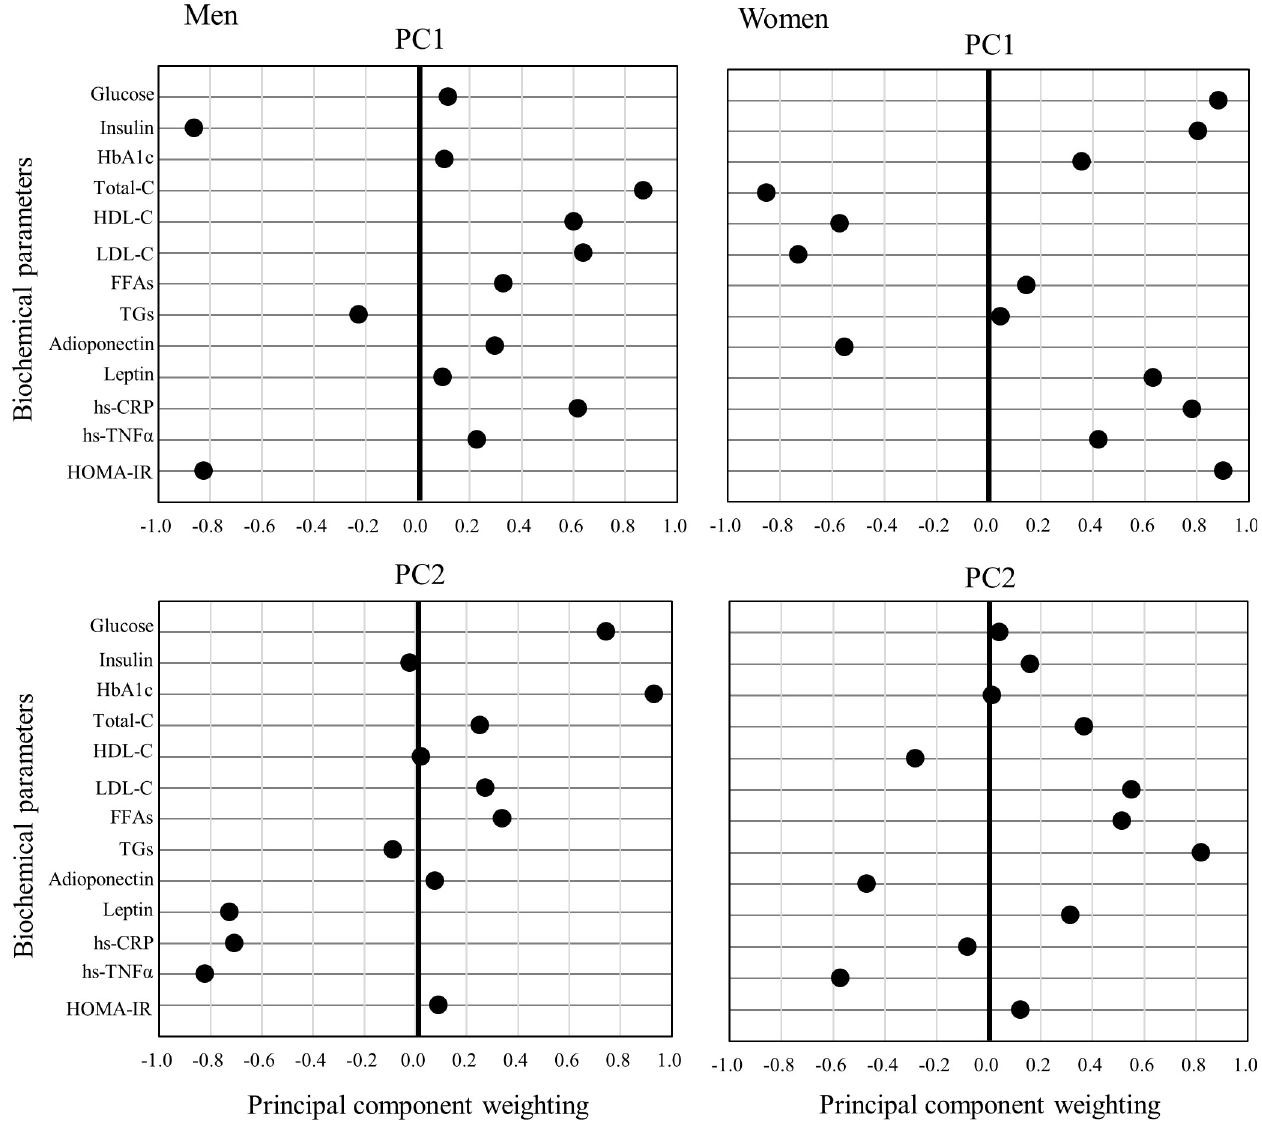
Fig 1. PC weighting in men (a, left side) and women (b, right side). FFAs, free fatty acids; HbA1c, hemoglobin A1c; HDL-C, high-density-lipoprotein cholesterol; HOMA-IR, homoeostasis model assessment index of insulin resistance; hs-CRP, high-sensitivity C-reactive protein; hs-TNF α , high-sensitivity tumor necrosis factor; LDL-C, low-density-lipoprotein cholesterol; TGs, triglycerides; Total-C, total cholesterol. PC weighting was significant ( >